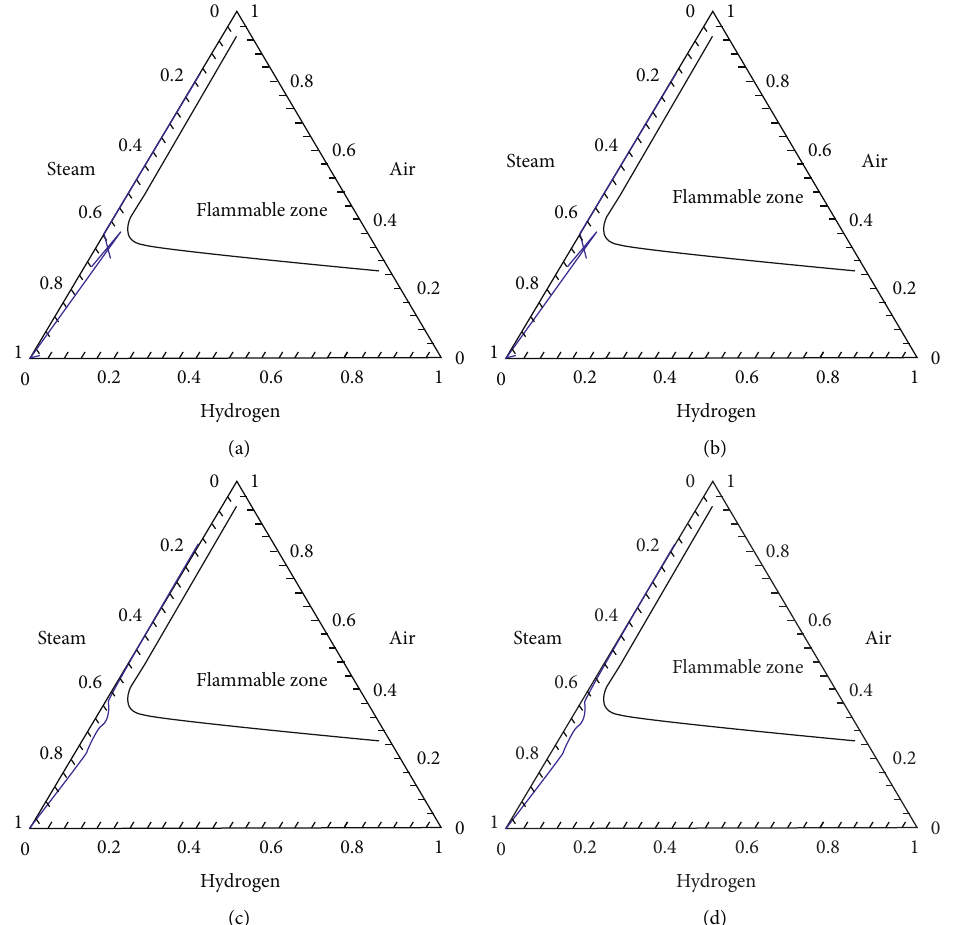
Figure 19: Shapiro diagram for each compartment. (a) Cavity compartment, ① ; (b) lower compartment, ② ; (c) upper compartment, ③ ; and (d) annular compartment, ④ .